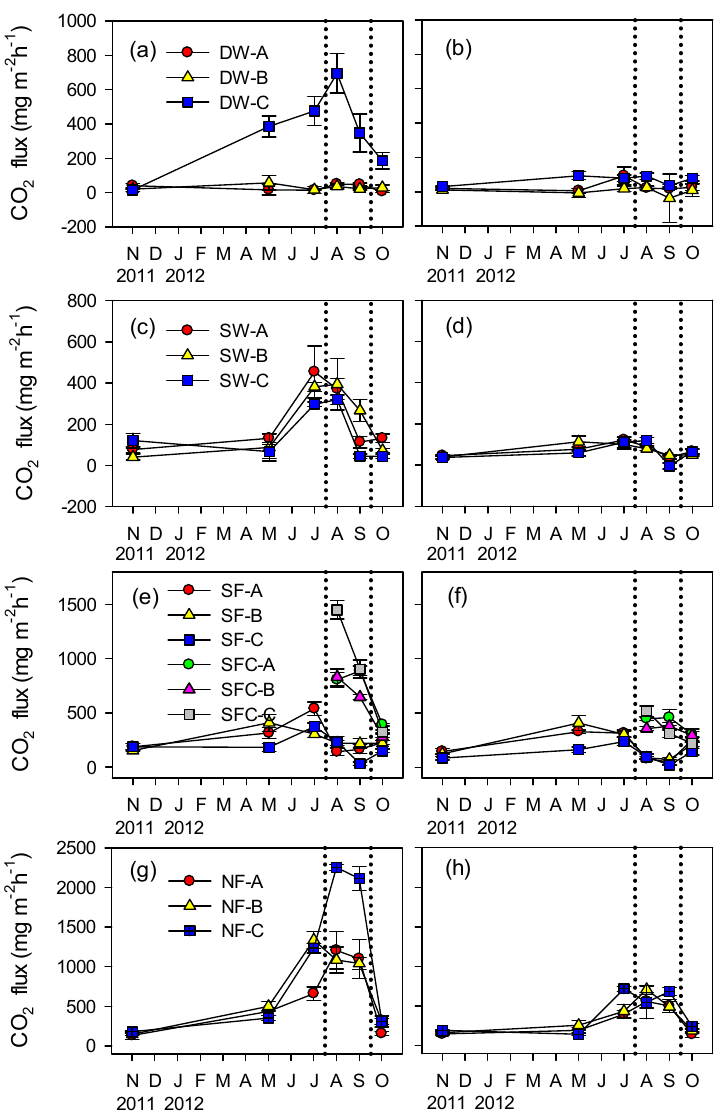
Figure 3. Influence of aboveground plant on monthly and spatial variation of CO 2 flux (mean ± SE). Subfigures show the CO 2 flux of site DW ( a , b ), SW ( c , d ), SF and its ‘control site’ SFC ( e , f ), and NF ( g , h ) respectively, with and without aboveground plant. The left plots were flux with aboveground vegetation while the right plots were flux after aboveground vegetation being removed. Days between dashed vertical lines were flooding period when seasonal flooded area was under water.